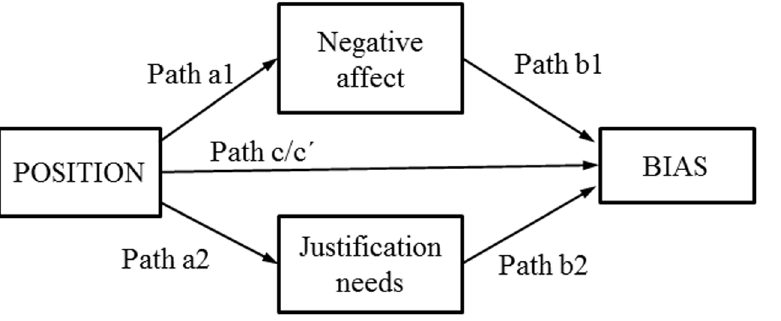
Figure 1. Proposed model, with needs to justify own opinion and negative affect toward the outgroup as mediators predicting biased perceptions. The paths refer to the paths being tested in the mediation